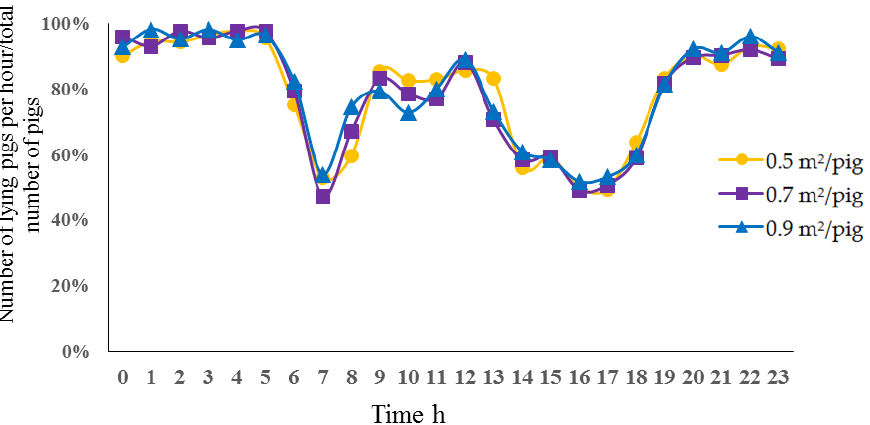
Figure 4. Daily variation in pigs’ lying.